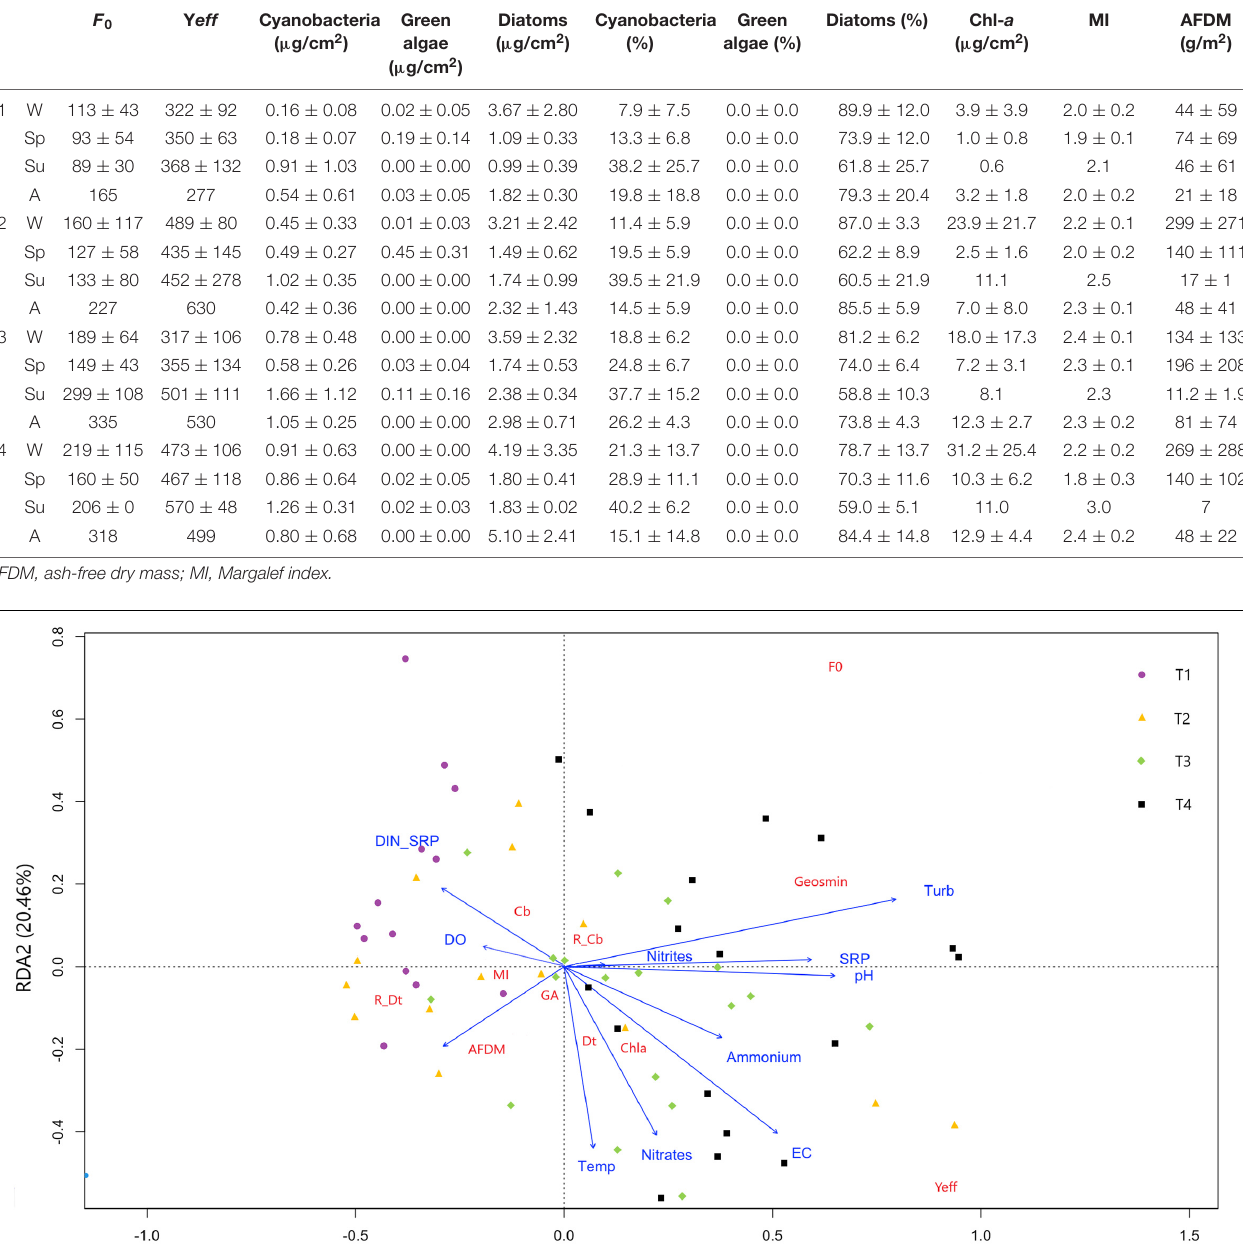
increases from 4.2 ◦ C in W1 to 9.5 ◦ C in W6, keeping with average values of 13.6 ± 1.7 ◦ C in spring. The same physicochemical parameters related to geosmin concentration are those that seem